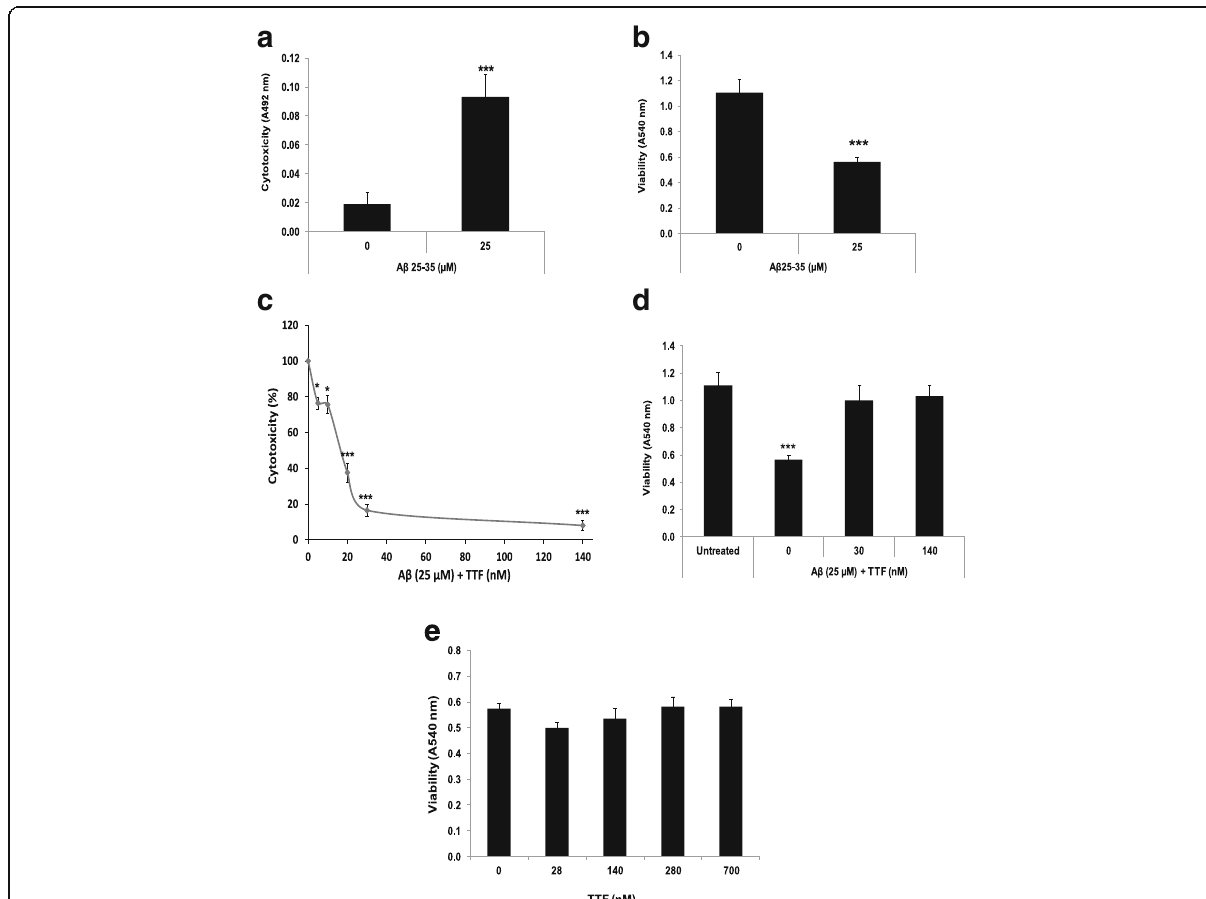
Fig. 2 TTF protects neuronal cells from A β -induced cell death . Neuronal cells were treated with A β 25 – 35 at 25 μ M, and cell death was determined 20 h later by (a) the LDH and (b) the crystal violet methods. Neuronal cells were treated with various concentrations of TTF, A β was added and cell death was determined 20 h later by (c) the LDH and (d) the crystal violet methods. The results are means ± SEM of two experiments ( n = 16); *** P < 0.001, for comparison of treated with untreated cells. The maximal LDH release after disruption of cells by Triton x-100 was A492 = 0.61 ± 0.04 as measured in two experiments ( n = 5). (e) Cells were treated with TTF alone, at various concentrations, and cell viability was determined 20 h later by the crystal violet method. The results are means ± SEM of two experiments ( n = 16). *** P < 0.001, for comparison with cells that were treated with A β